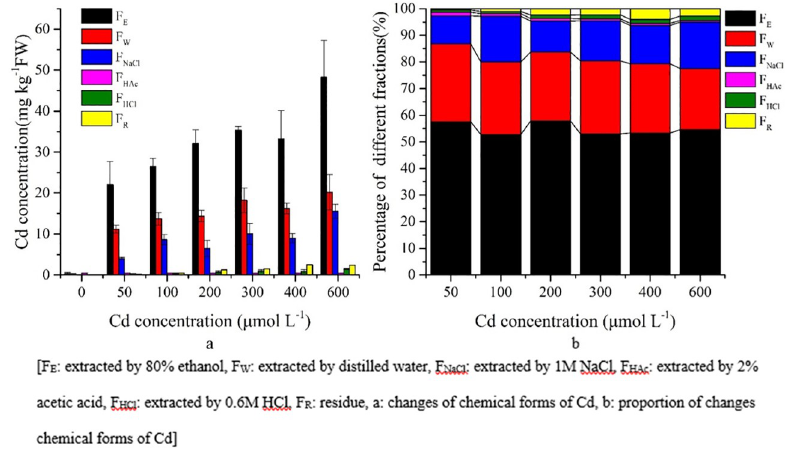
Fig 8. Chemical forms of Cd and proportions in S . portulacastrum roots.